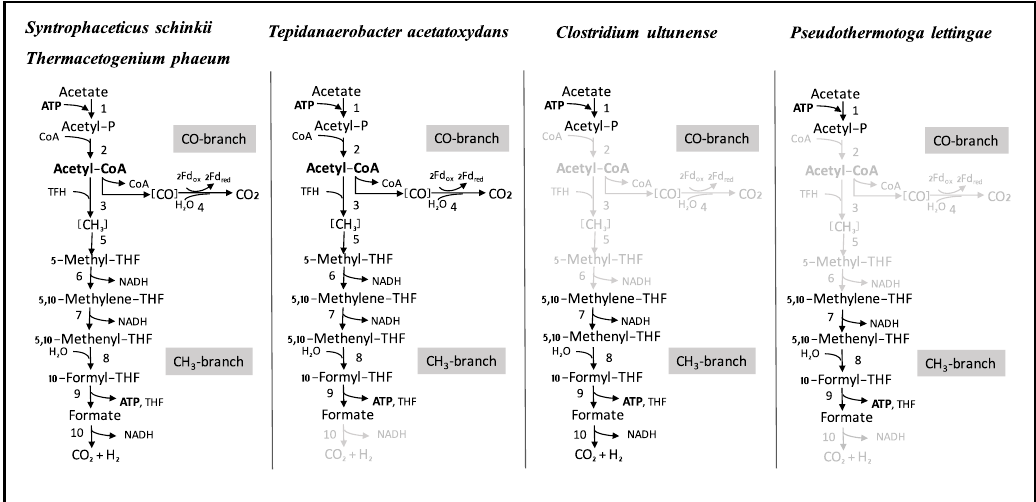
Figure 4. Wood-Ljungdahl (WL) pathway proteins encoded by the genomes of the SAOB S. schinkii , Th. phaeum , T. acetatoxydans , C. ultunense Esp/BS T , and P. lettingae . (1) Acetate kinase, (2) phosphotransacetylase, (3) acetyl CoA synthetase complex (including corrinoid protein), (4) carbon monoxide dehydrogenase, (5) methyl transferase, (6) methylene THF reductase, (7) methylene tetrahydrofolate (THF) dehydrogenase, (8) methenyl THF cyclohydrolase, (9) formyl THF synthetase, (10) formate dehydrogenase. Functions displayed in light grey are not encoded.